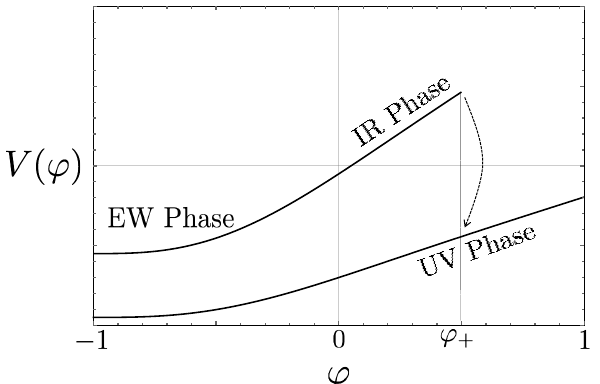
Figure 9 . A sketch of the scalar potential V ( ϕ, h h i ) with the three branches corresponding to the EW, IR and UV Higgs phases. For ϕ < ϕ , two Higgs phases coexist. + where x = x = 1 /e . Beyond ϕ , the potential is a monotonically decreasing function of 1 2 + h and the IR vacuum no longer